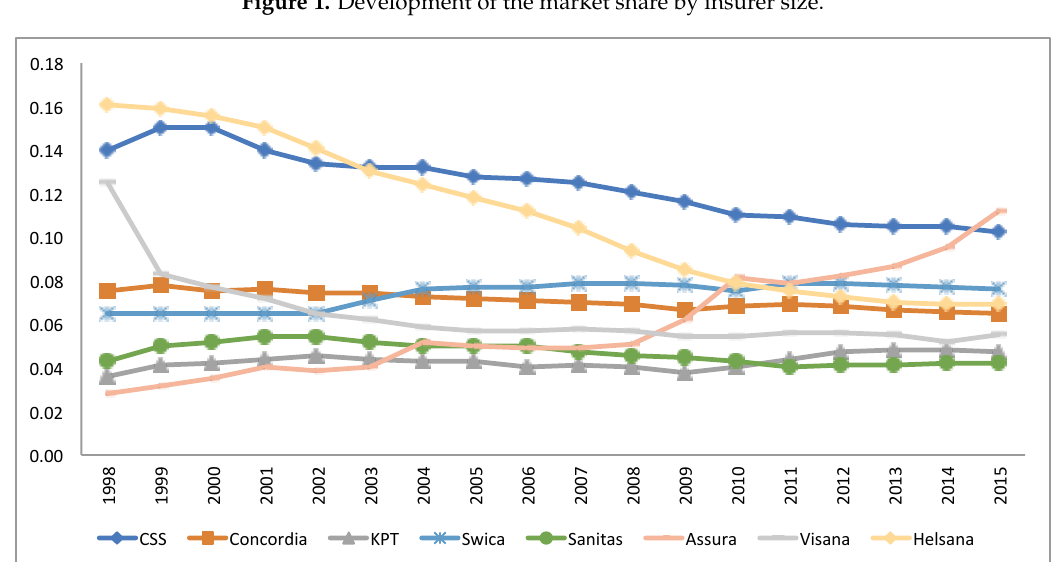
Figure 2. Development of the market share of the eight largest